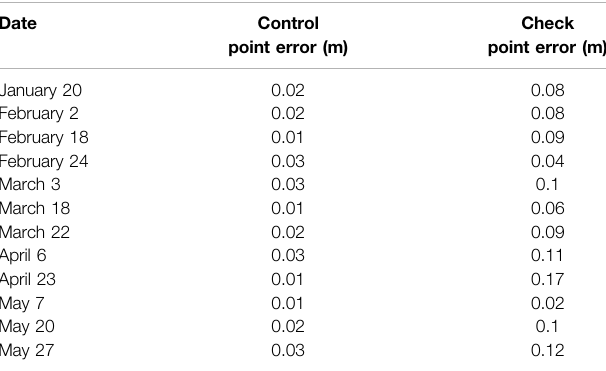
TABLE 1 | Control and Check Point Errors for the twelve SfM surveys (eleven snow-on and one snow-off).